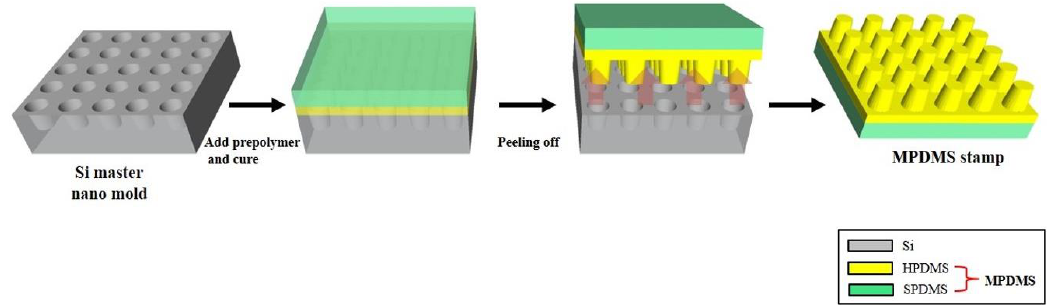
Figure 1. Schematic illustrations of the replica molding process for fabricating the modified PDMS (MPDMS) stamp from the Si master nano-mold.